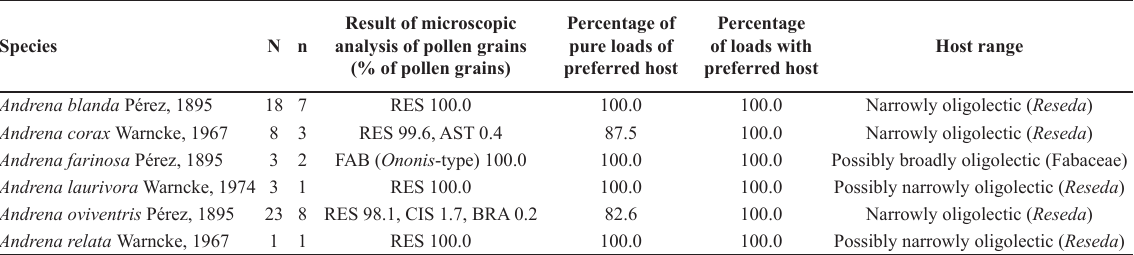
Table 2. Plant host use and dietary categories for selected Iberian species of Andrena Fabricius, 1775 formerly placed in the subgenus Poliandrena Warncke, 1968. Abbreviations: N = number of analysed pollen loads; n = number of unique sampling localities. Plant taxa: AST = Asteraceae; BRA = Brassicaceae; CIS = Cistaceae; FAB = Fabaceae; RES =